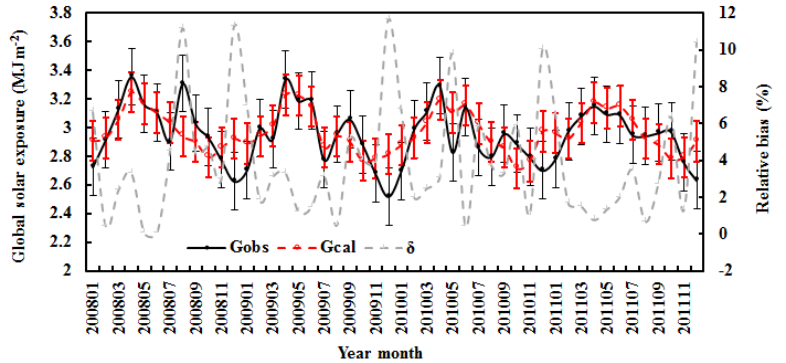
Figure 2. The observed and calculated monthly averages of hourly global solar exposure (G obs and G cal ) and relative biases ( δ ) in all-sky conditions at the Qomolangma site. The error bars show the standard deviations of the observed and calculated values (1 σ , red for the calculated values).